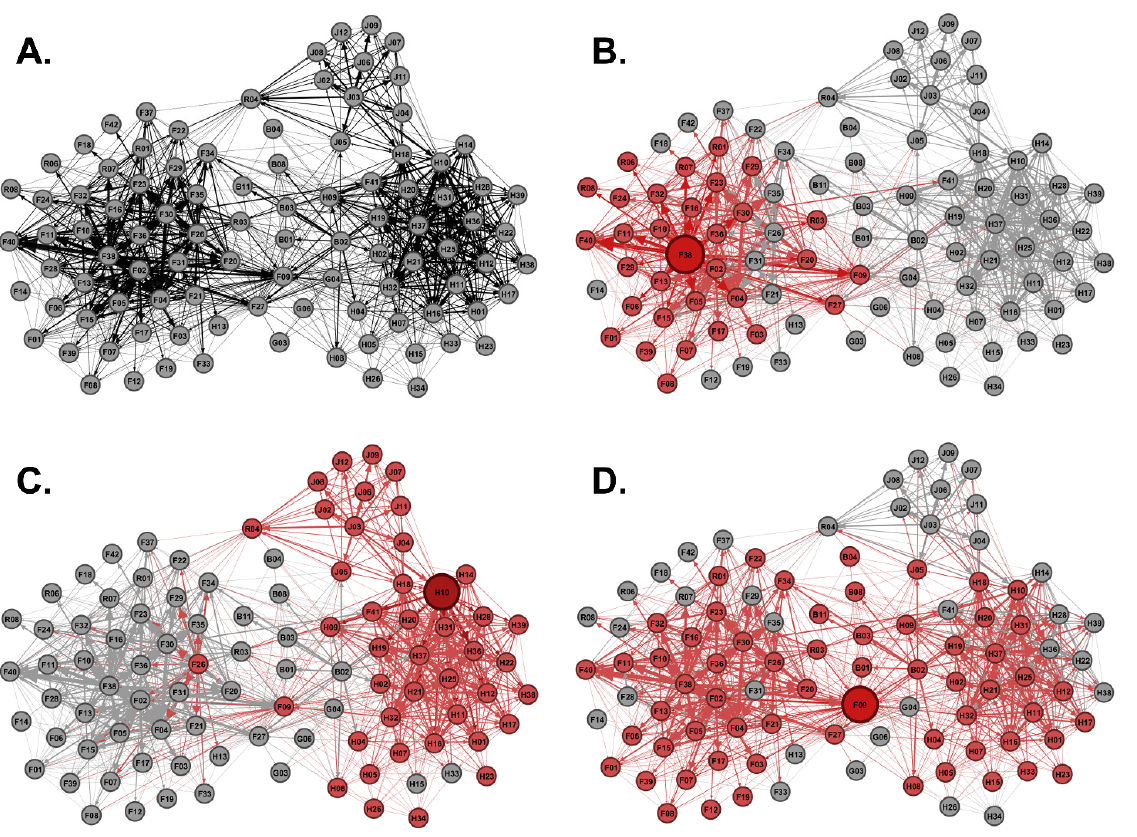
Figure 4. Modeling Potential Super-Spreaders. ( A ) Shown is the Regional Network generated from Major Sites 1, 2, and 3 as well as boundary sites’ scraping data. ( B ) Shown is the disease transmission risk of the highest-ranking out-degree potential super-spreader within the Regional Network, where the infected node F38 is enlarged and colored red forming 31 direct contacts. Contact nodes and weighted edges are also colored red to emphasize risk. ( C ) Shown is the disease transmission risk of the highest-ranking in-degree potential super-spreader, where the infected node H10 forms 42 direct contacts. ( D ) Shown is the disease transmission risk of the highest-ranking betweenness potential super-spreader, where the infected node F09 forms 61 direct contacts.